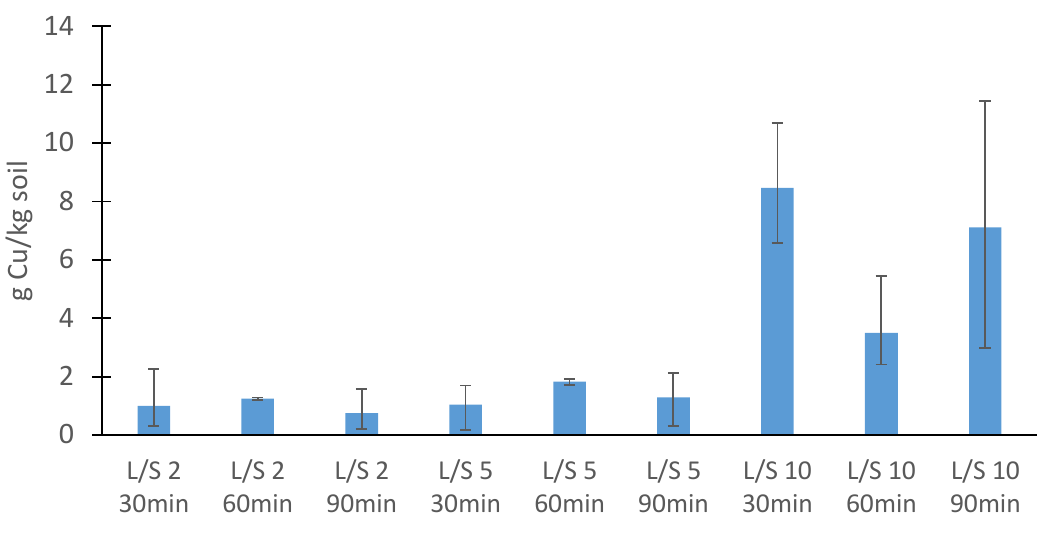
Figure 4. Cu leached from the A2 soil sample at varying leaching times (30–90 min) and L/S-ratios (2, 5 and 10). The columns show the average of three replicate tests. The error bars show the maximum and minimum